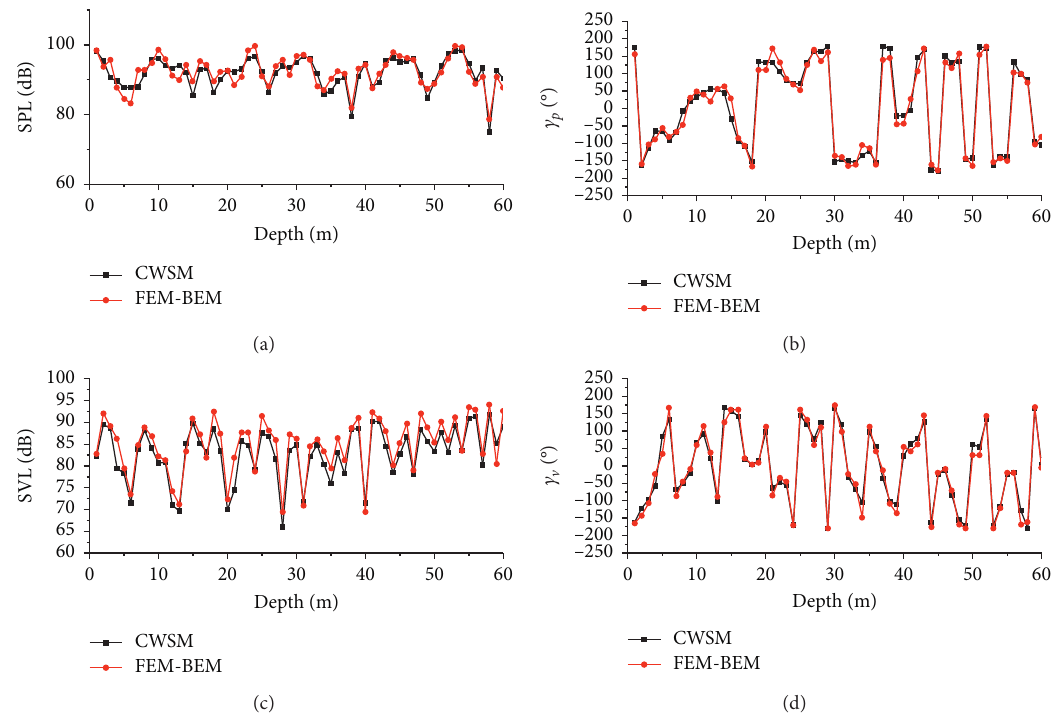
Figure 8: Comparisons of the CWSM with the FEM-BEM at the frequency of 360Hz. (a) SPL. (b) c � 1600kg/m 3 ρ 1